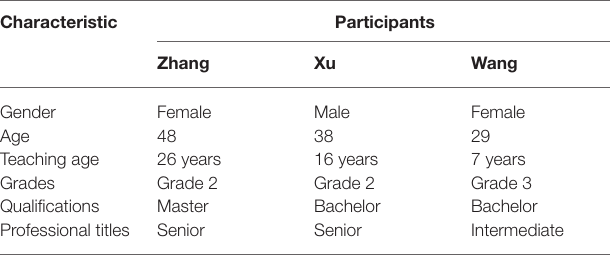
TABLE 1 | Profile of the case study participants.